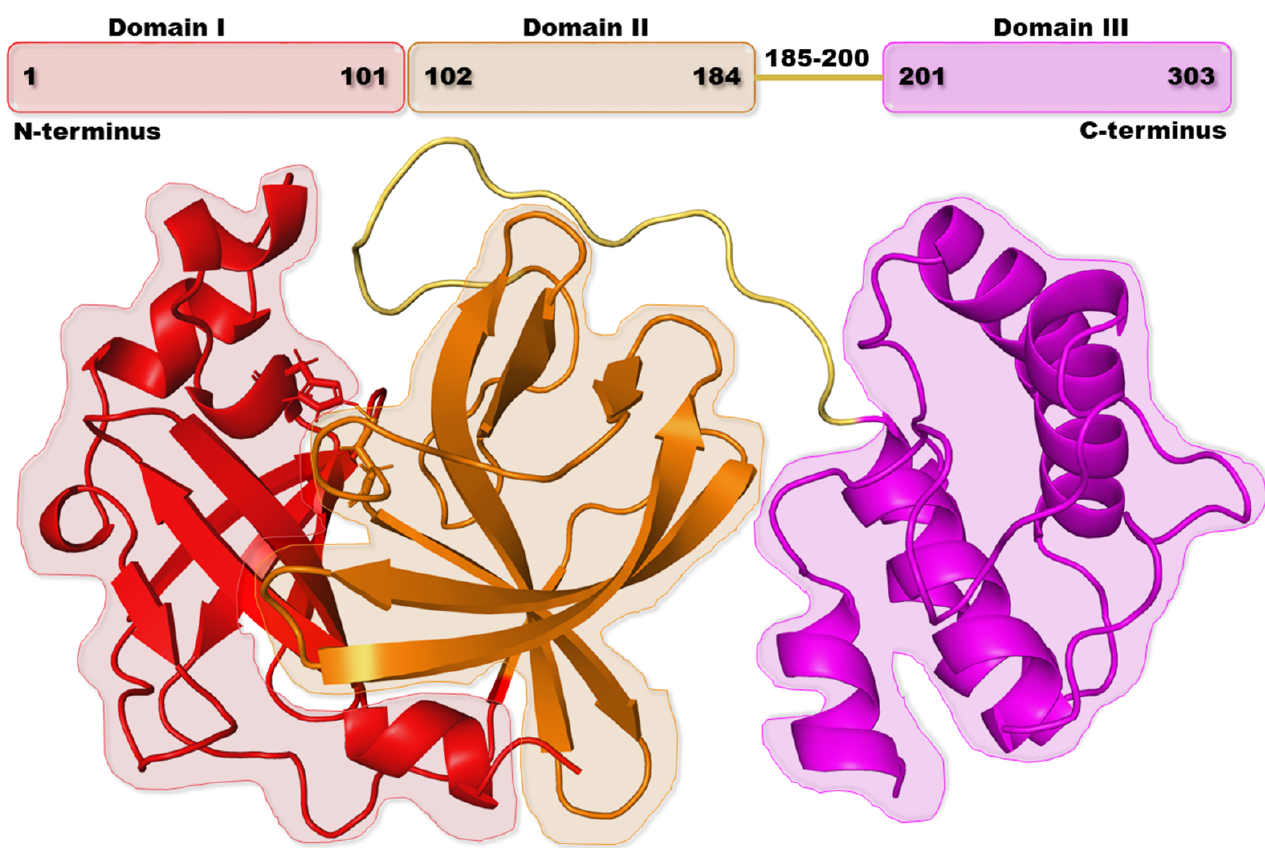
Figure 1. Domain organization and structural view of the 3CL pro enzyme.